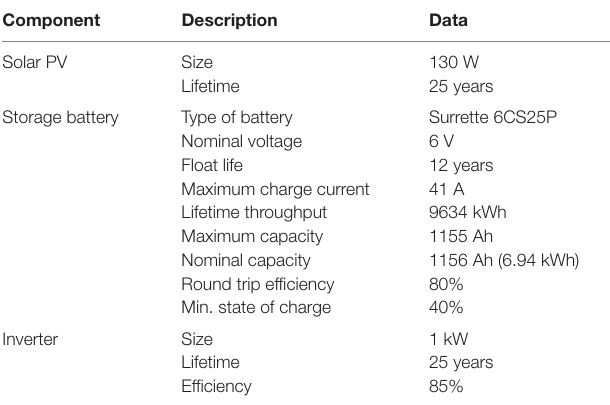
TaBle 3 | Data for components system – solar and its balance of system (BOs) components.